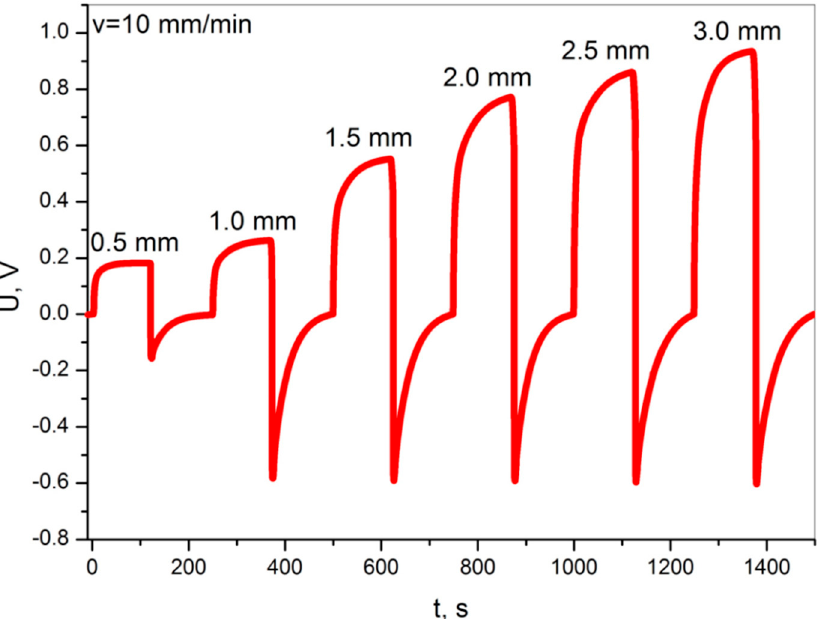
Figure 5. Voltage diagrams obtained during the non-destructive static bending tests at a constant bending rate 10 mm / min, and with a variable deflection of 0.5–3.0 mm.